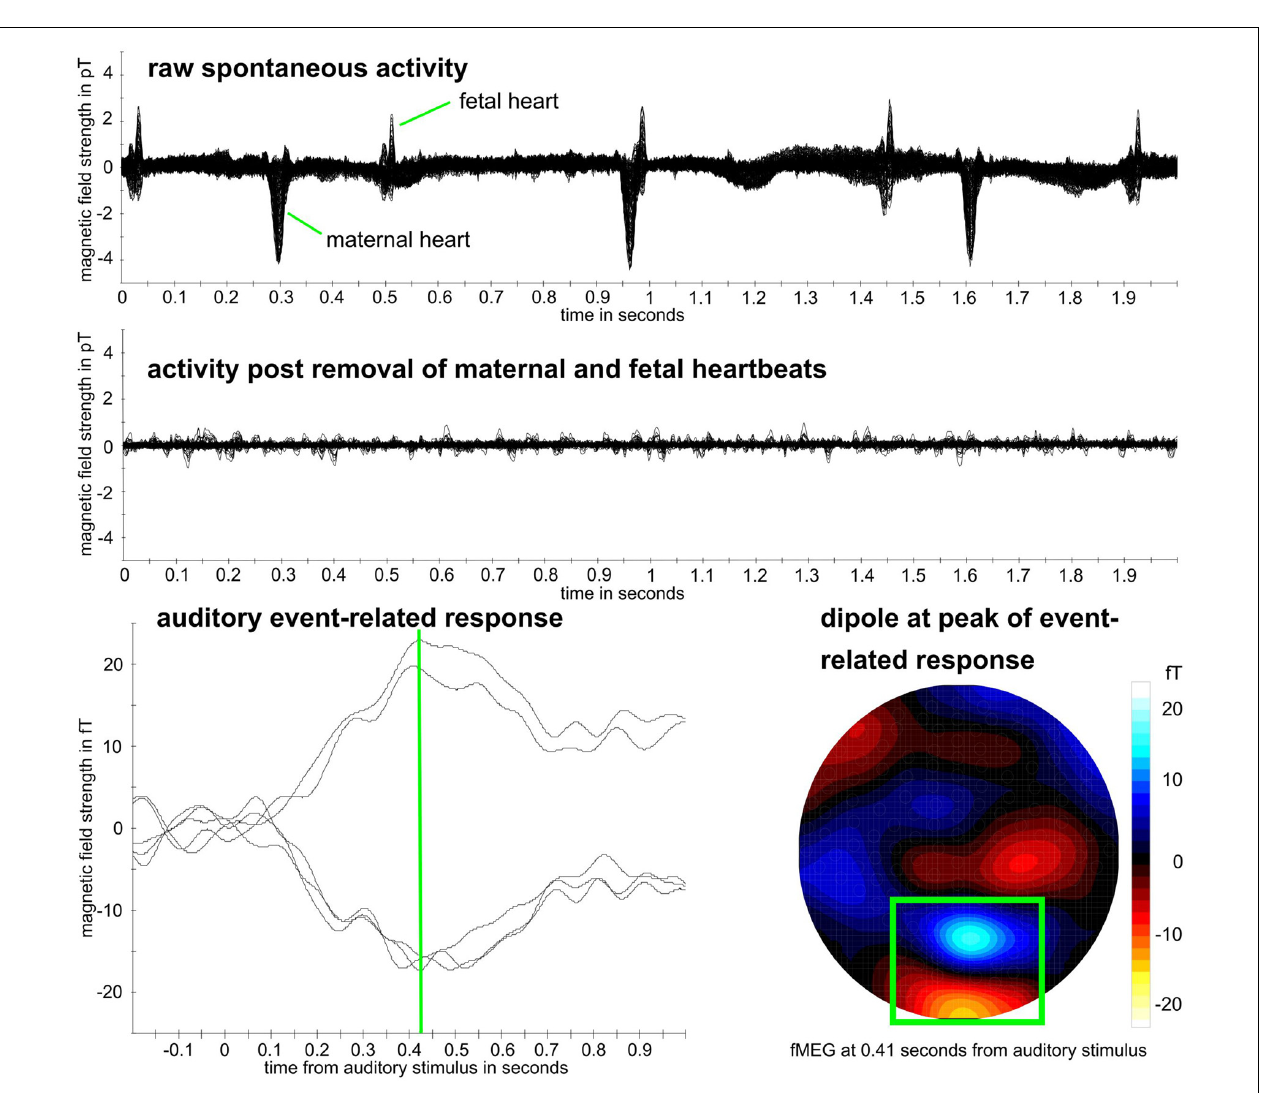
FIGURE 2 | Example fetal magnetoencephalography (fMEG) dataset. Recording from subject in 38th week of gestation. Top: raw fMEG data trace, overlay of all channels. Middle: trace after removal of maternal and fetal heart activity. Bottom: auditory event-related response. Green rectangle marks dipole that represents fetal brain activity. Event-related peak from five strongest channels within this dipole is shown, whereas peak time is marked in